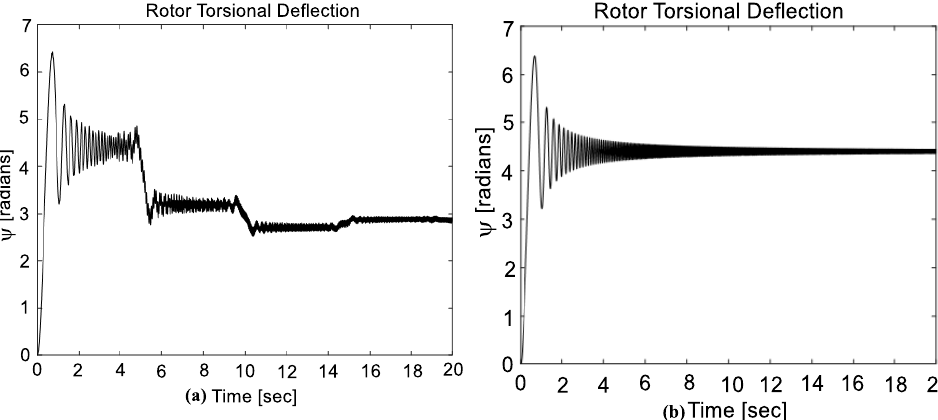
Figure 7. Torsional response of the imbalanced drill string-casing system with rub in an inviscid fluid. ( a ) Torsional in air; ( b ) Torsional in an inviscid fluid